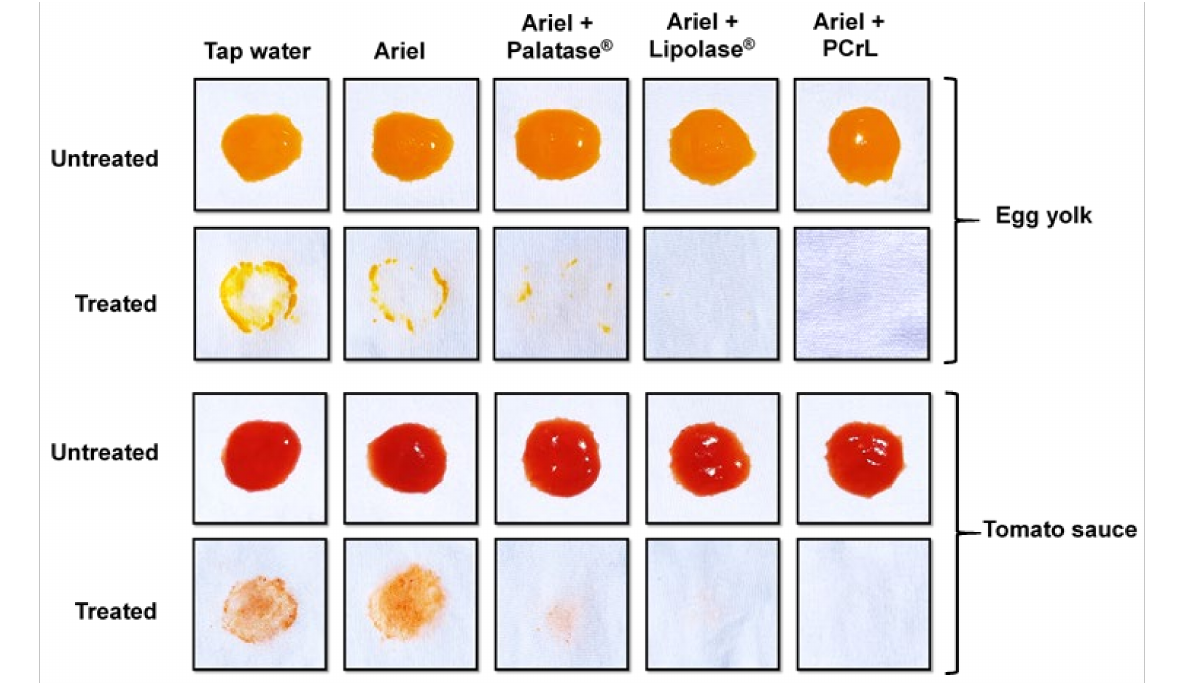
Figure 10. Wash performance test on oil removal with a commercial detergent in the presence of PCrL, Palatase ® 20000 L, or Lipolase ® . The washing performance analysis test of the lipase was conducted with the commercial detergent Ariel (7 mg/mL) using cotton cloth stained with egg yolk or tomato sauce. The oil-stained cloth was rinsed with tap water, washed with Ariel (7 mg/mL), washed with Ariel supplemented with Palatase ® 20000 L (500 U/mL), washed with Ariel supplemented with Lipolase ® (500 U/mL), or washed with Ariel supplemented with PCrL (500 U/mL). Table 6. Effect of PCrL, Palatase ® 20000 L, and Lipolase ® on the removal of olive oil from cotton fabric with various marketed liquid and solid laundry